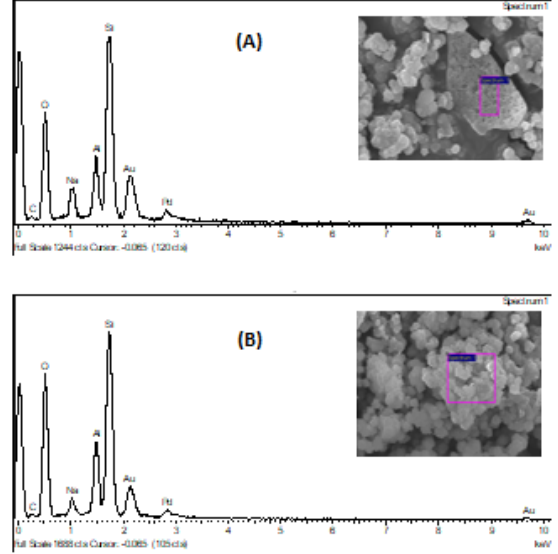
Figure 14. EDS spectra of: ( A ) z. HY catalyst sample collected before the activation process and ( B ) same catalyst sample collected after the activation process.